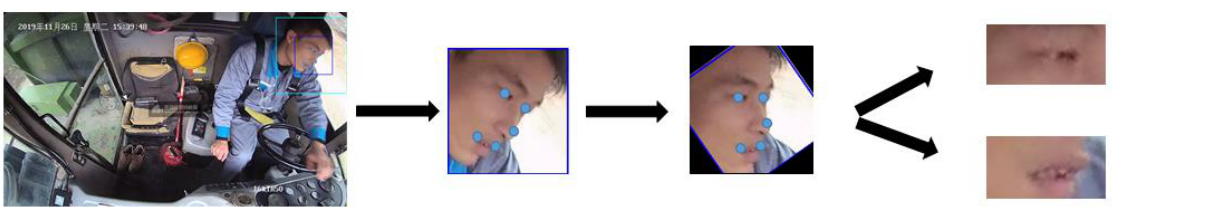
Figure 7. Sample preparation and processing.